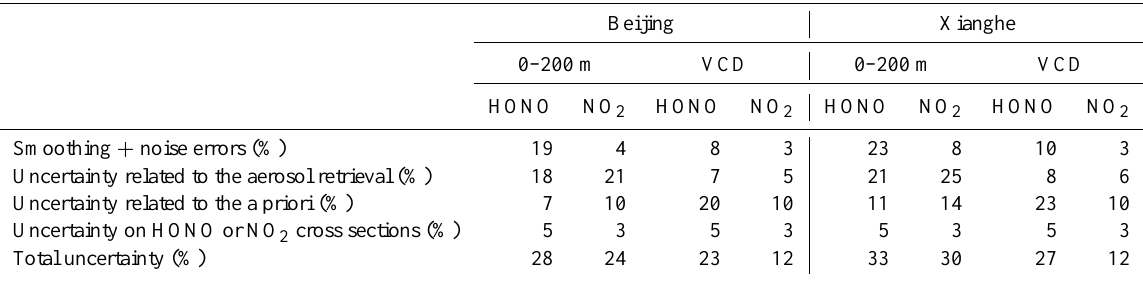
Table 1. Error budget of the retrieved HONO and NO 2 near-surface (0–200m) concentrations and vertical column densities (VCD). The total uncertainty is calculated by adding the different error terms in Gaussian quadrature. Beijing